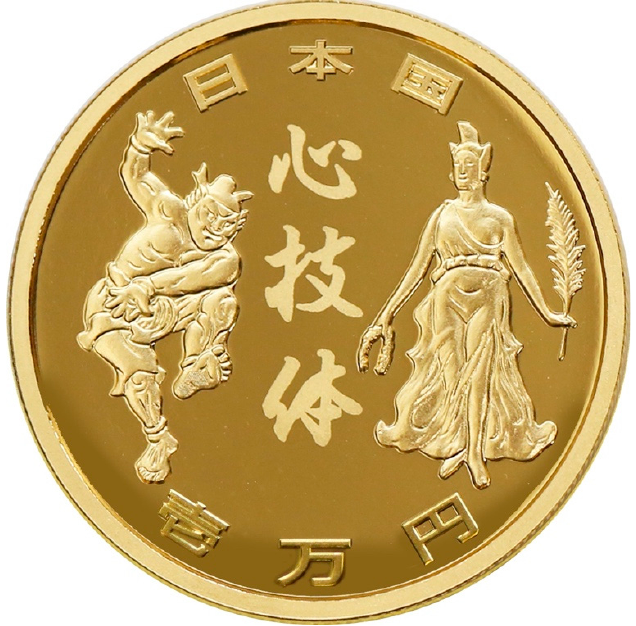
Figure 2. Obverse of Tokyo 2020 Official Licensed 10,000-yen commemorative gold coin. Repro- duced with permission from Japan Mint and the IOC.